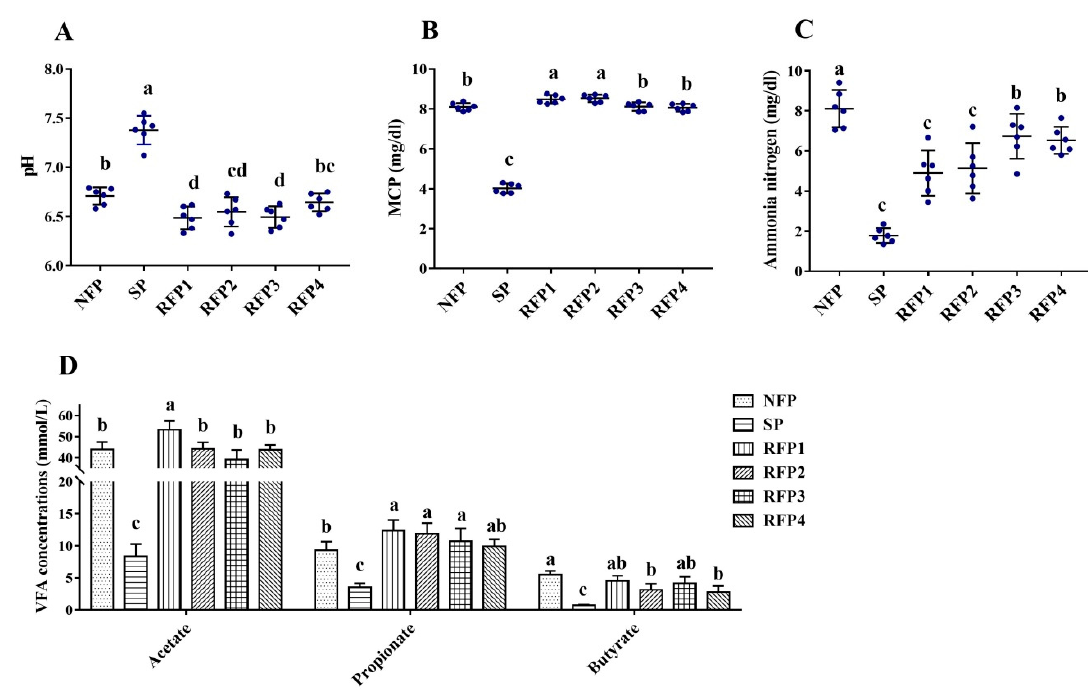
Figure 3. The fluctuations of microbial fermentation parameters, including pH ( A ), MCP (microbial protein) ( B ), ammonia nitrogen ( C ) and VFAs (volatile fatty acids) ( D ), of yaks through the normal feeding (NFP), starvation (SP) and prolonged refeeding (RFP1-4) periods. Values are means ± SD ( n = 6). Different small letter superscripts represented significantly different ( p < 0.05).